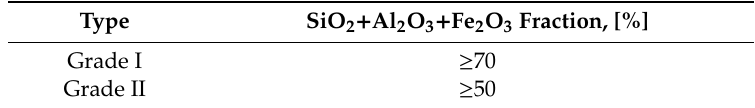
Table 3. Type of fly ash as per S 3812-1981.